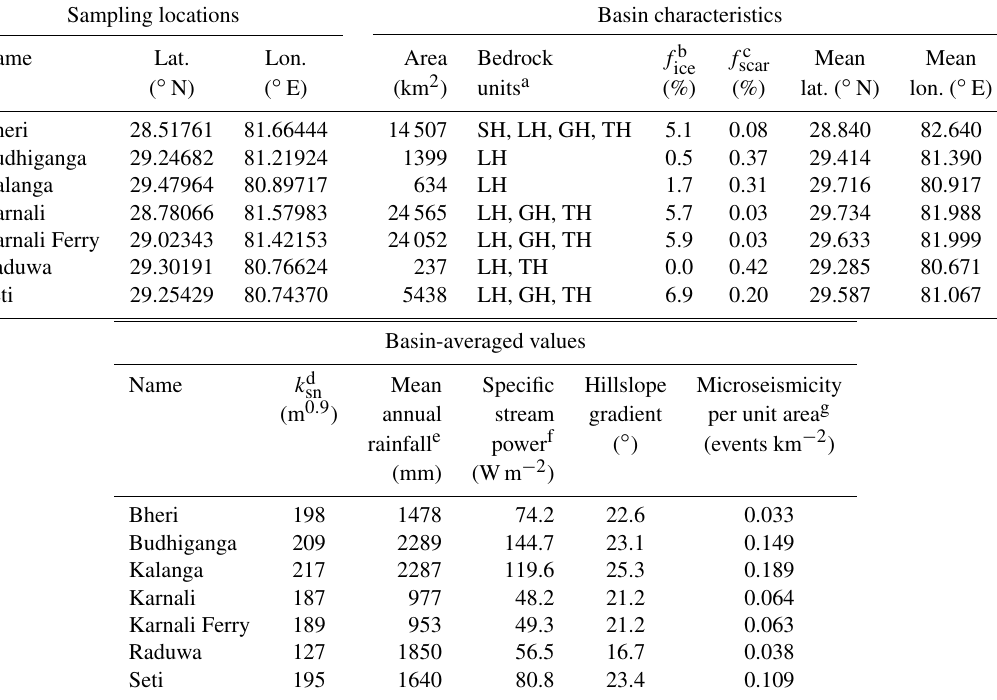
Table 1. Stream sediment sampling sites and upstream basin characteristics. Sampling